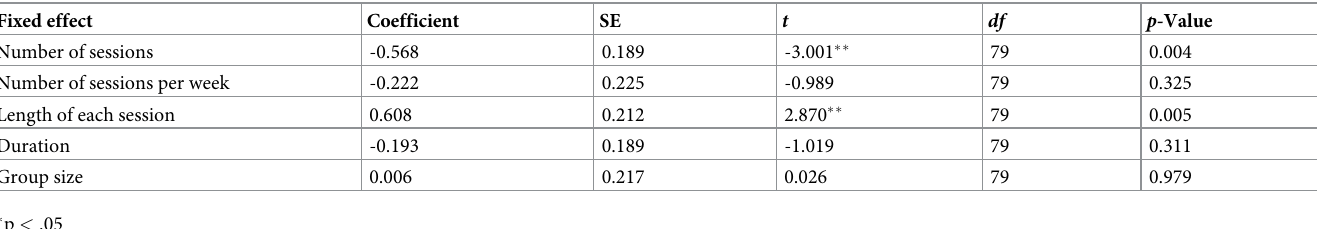
Table 12. Results of the conditional model with intervention-related variables as